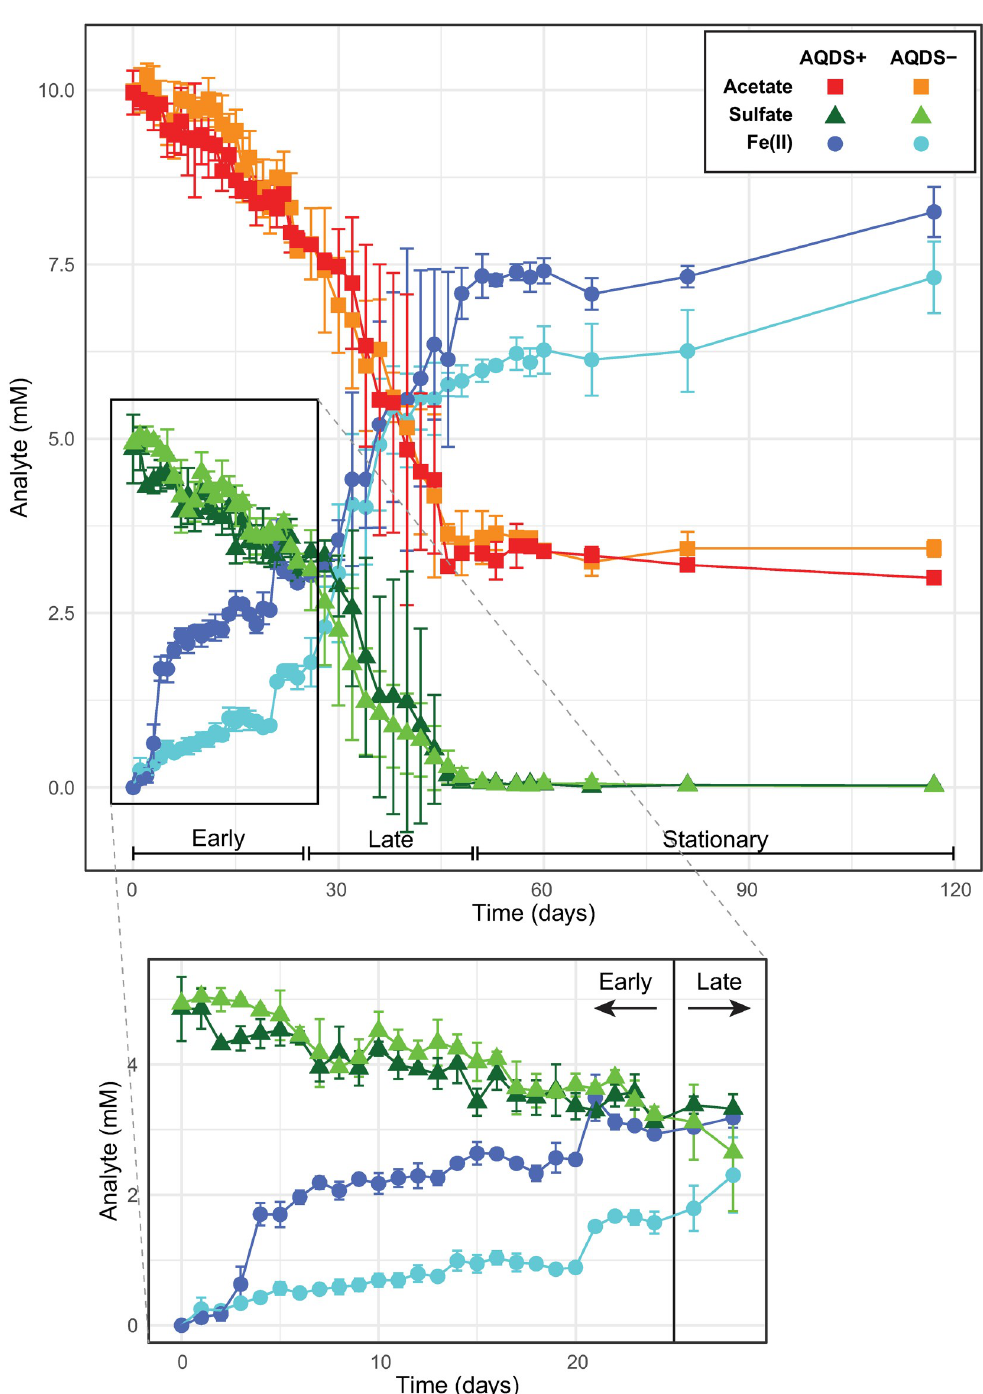
Fig 1. Analyte concentrations in bioreactors. Concentrations of total ferrous iron (Fe II ), acetate, and sulfate over time in AQDS–amended (AQDS+) and control bioreactors (AQDS–) with an expanded view of Fe II and sulfate concentrations from 0–28